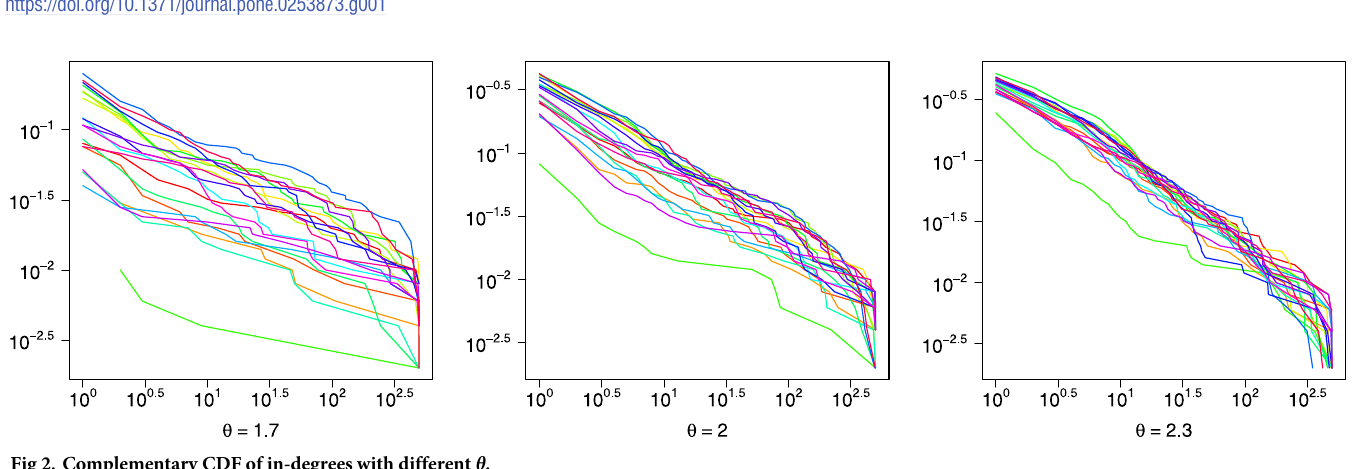
Fig 2. Complementary CDF of in-degrees with different θ .